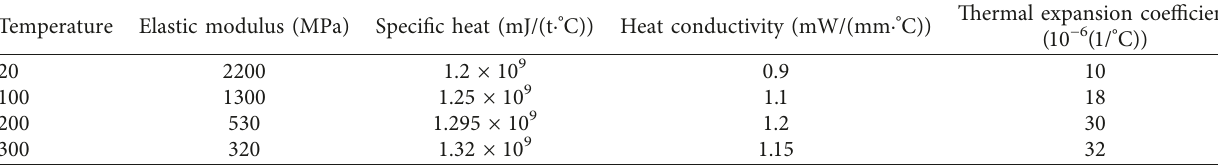
Table 3: Thermophysical properties of the brake pad.